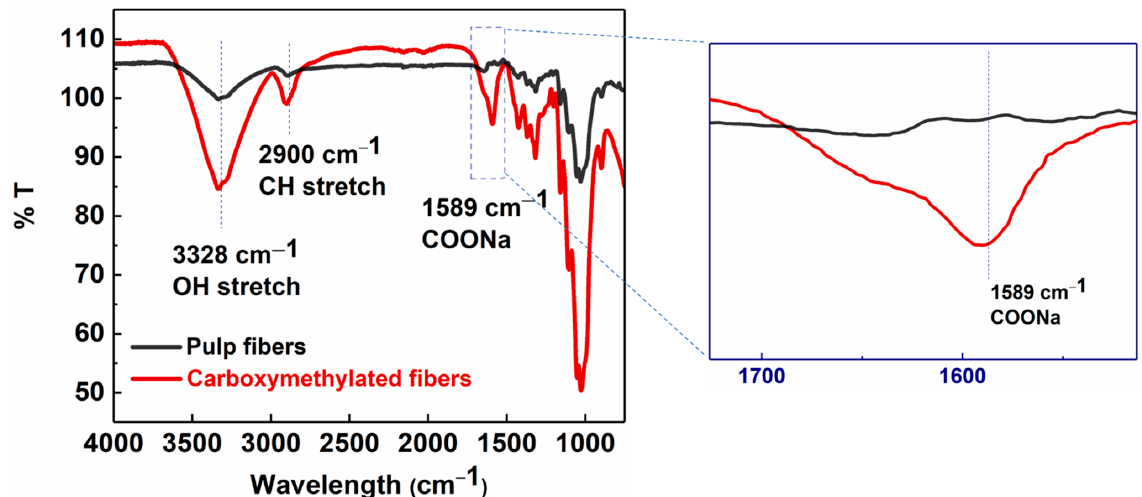
Figure 3. FTIR analysis of carboxymethylated (red) and pulp fibers (black).